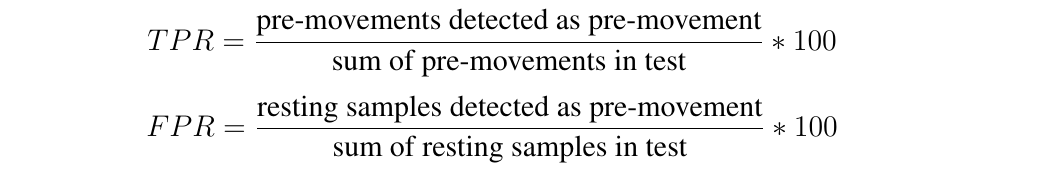
Table 1. Results for all users and classifiers. TPR and FPR are in percentages, and GAP is the division between TPR and FPR. SMO, sequential minimal optimization; QP, quadratic programming; NB, naive